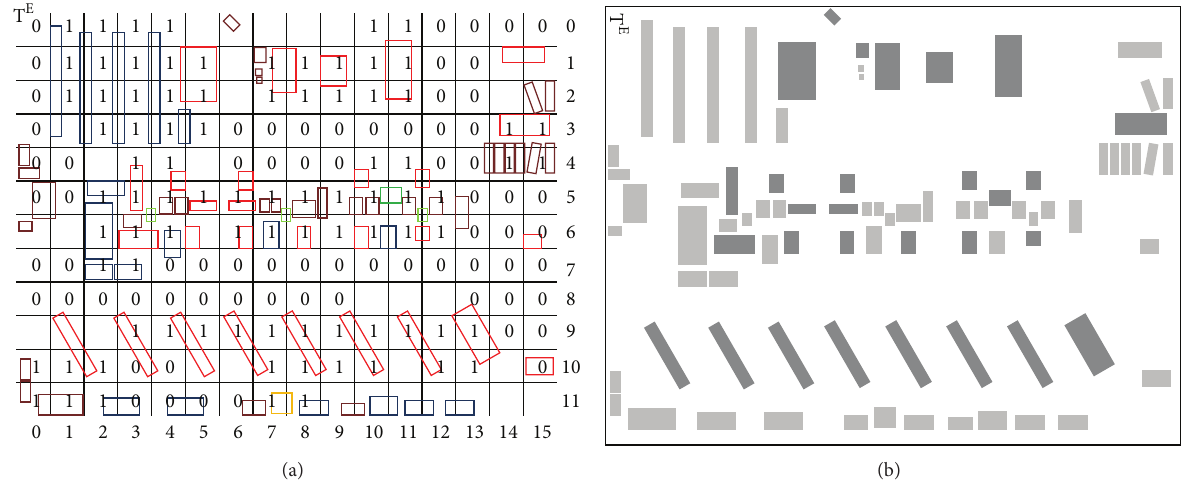
Figure 3: (a) Real grid ( real[i][j] ) with areas affected by attenuation (marked with 1) and favorable paths (marked with 0) (b) dividing obstacles in machine tools and large obstacles (dark gray) and smaller obstacles (gray).